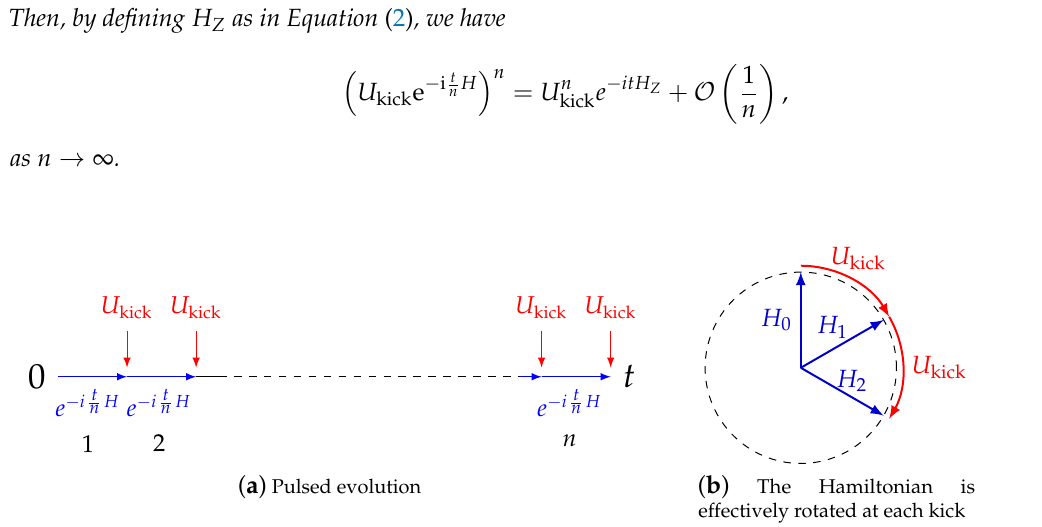
Figure 2. ( a ) Alternating free evolutions of duration t / n with instantaneous unitary kicks U kick ( b ) is equivalent to a sequence of infinitesimal evolutions of duration t / n generated by Hamiltonians H (cid:96) = U † (cid:96) HU (cid:96) rotated at each step by the unitary kick. kick kick